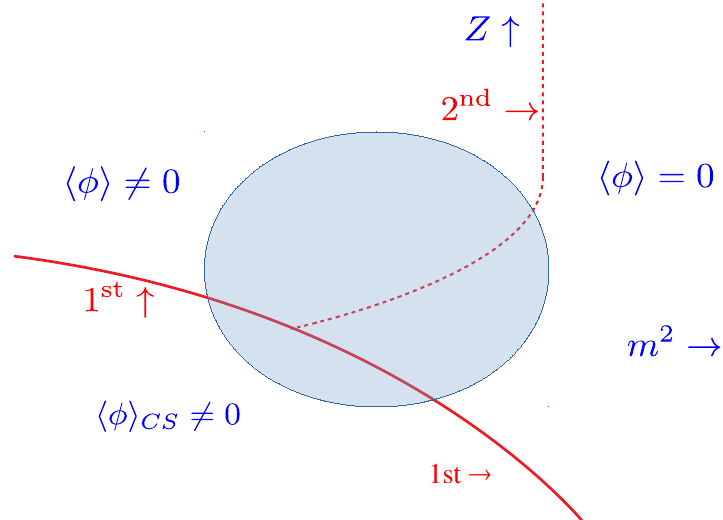
Figure 5. The proposed phase diagram, including all fluctuations. The axes Z and m are not indicated, because the Lifshitz point, with Z = m 2 = 0, is not accessible. The shaded region is the Lifshitz regime, where Z and/or m 2 are generated non-perturbatively due to strong infrared